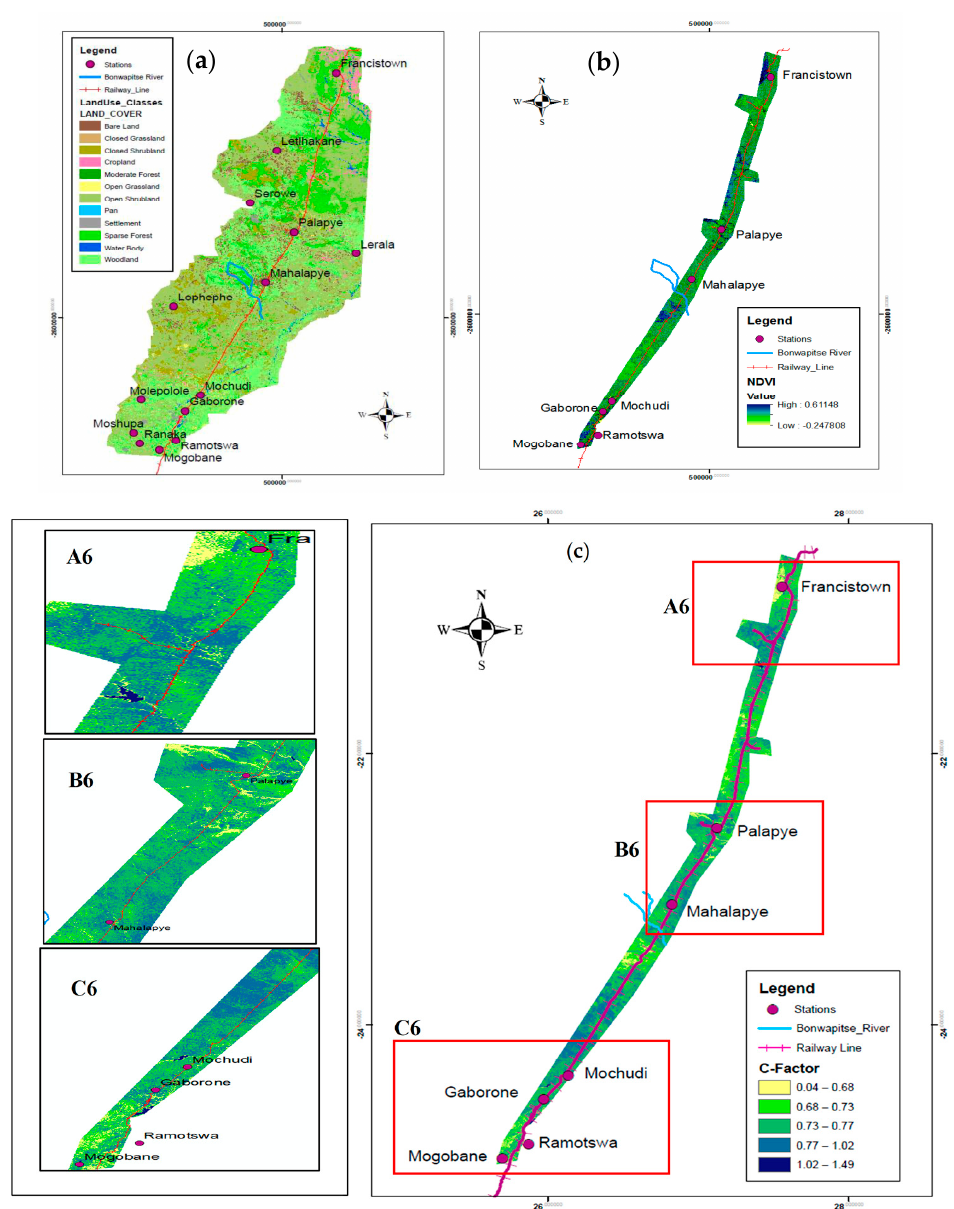
Figure 7. ( a ) LULC for the BLRB. ( b ) NDVI for the BRC. ( c ) C-factor of the BRC.